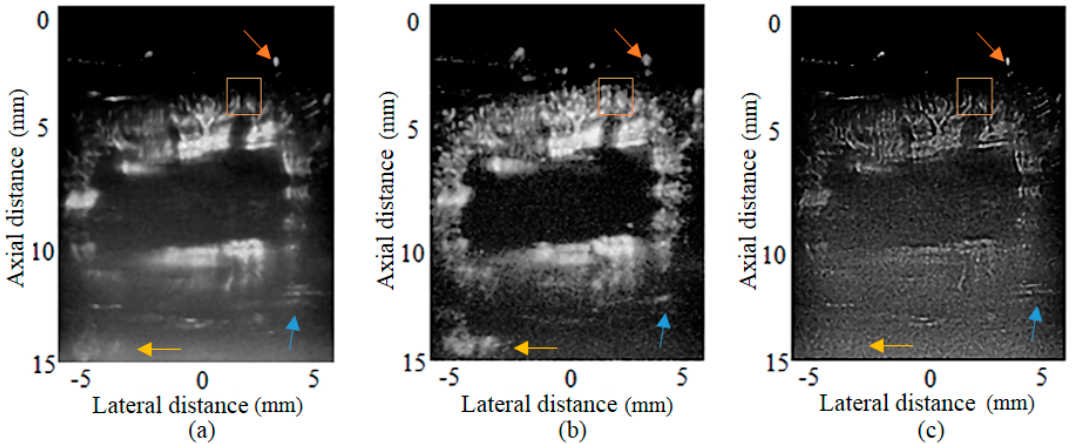
Figure 4. The super-resolution construction imaging results of rabbit kidney using: ( a ) Gaussian PSF deconvolution + scatter plot, ( b ) High-order moment calculation + power Doppler integration, and ( c ) Integral form of Gaussian PSF deconvolution + ASH respectively. All images are shown with a dynamic range of 50 dB. The orange, yellow and blue arrows point to the point target, artefact and the vascular details respectively. The orange box marks the area we choose to enlarge. 21Appl. Sci. 2018 , 8 , x